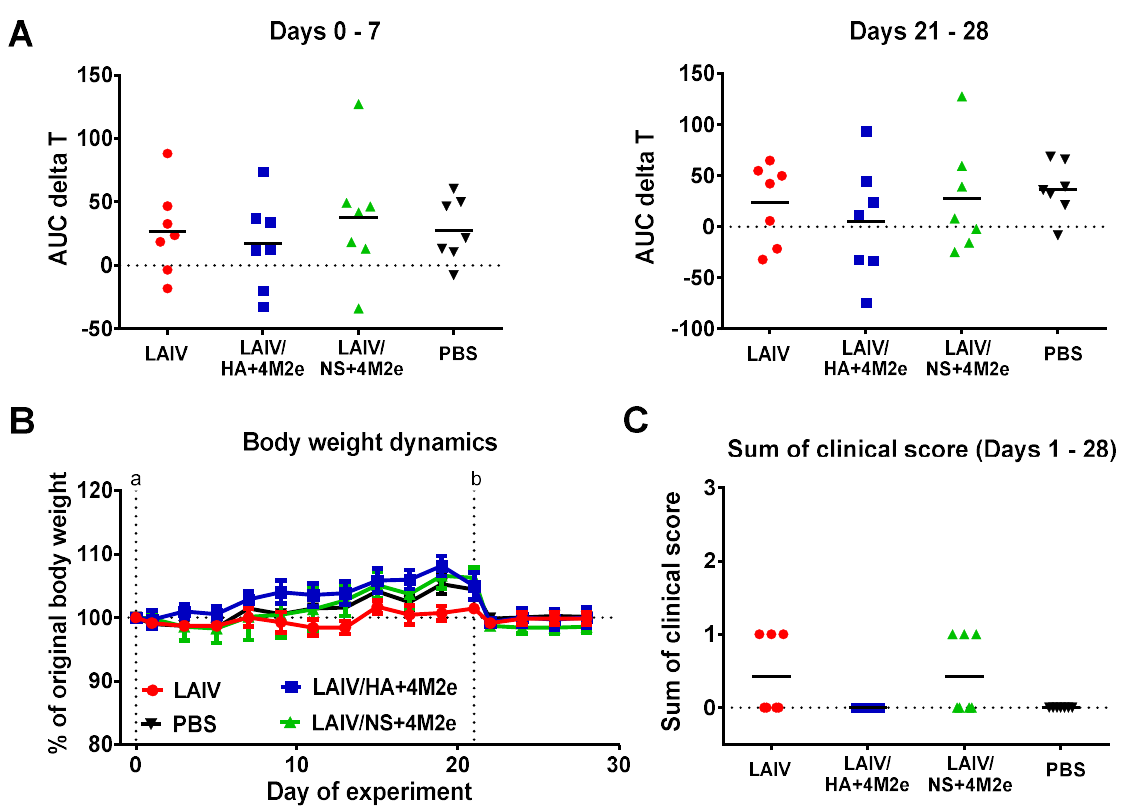
Figure 5. Safety of the LAIV candidates in ferrets as measured by clinical outcomes. ( A ) Area under the curve (AUC) of delta T values for individual ferrets during one week after the first vaccine dose (left graph) and during one week after the second vaccine dose (right graph). ( B ) Ferrets’ body weight dynamics after the first (a) and the second (b) dose of the vaccines or placebo. ( C ) Sum of clinical scores for each animal during 28 days of the experiment.